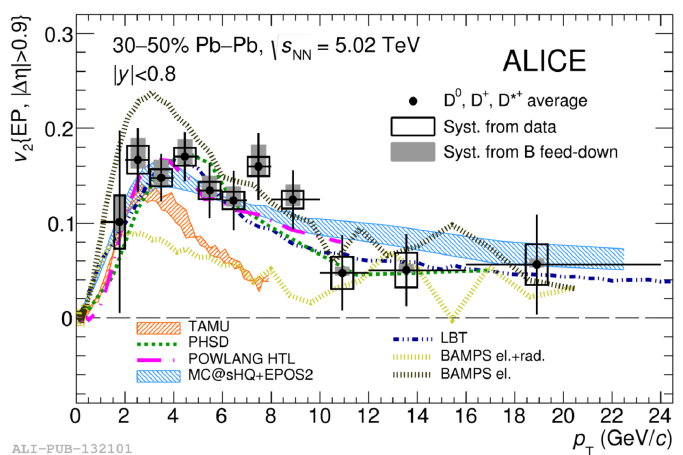
Figure 13. v 2 of D mesons in semi-central collisions. Figure taken from [29].